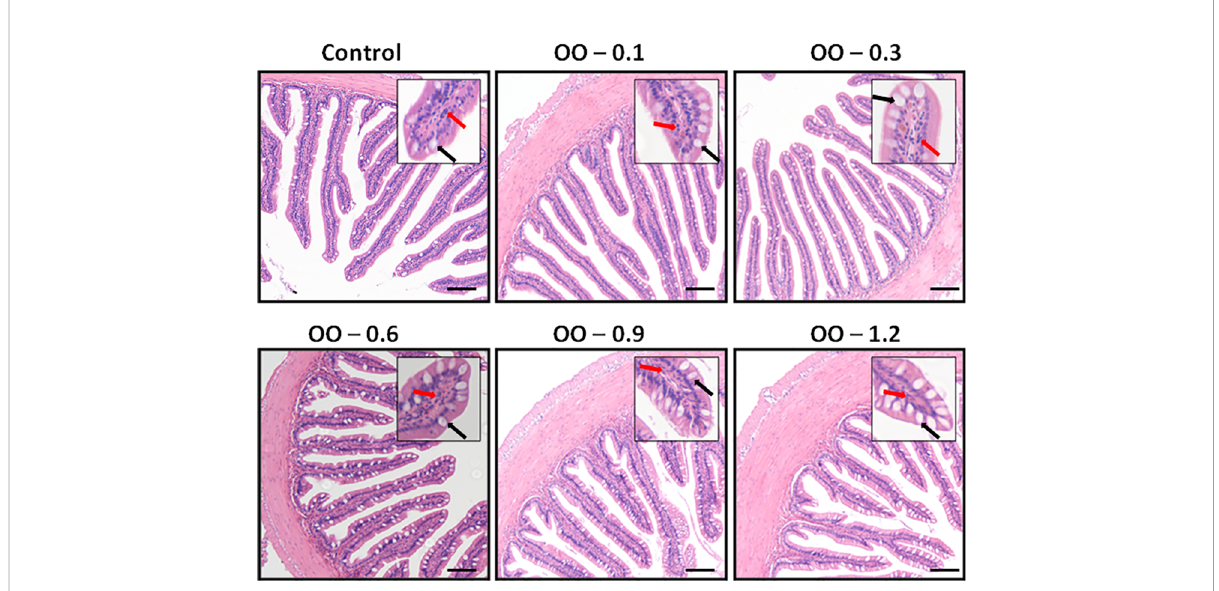
FIGURE 2 Effect of dietary oregano oil (OO) on the intestinal morphology of juvenile hybrid grouper fed the experimental diets for 8 weeks. Black arrow: goblet cell; red arrow: epithelioid cell. Scale size: 200 m